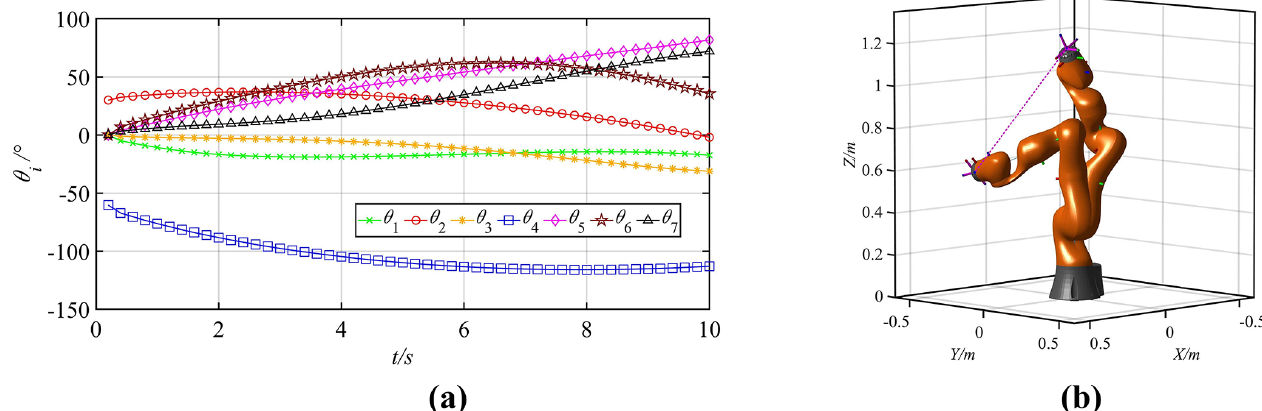
Figure 21. Motion curves of the joints and the manipulator (7 DOFs). (a) Joint motion curves. (b) Trajectory of the manipulator.